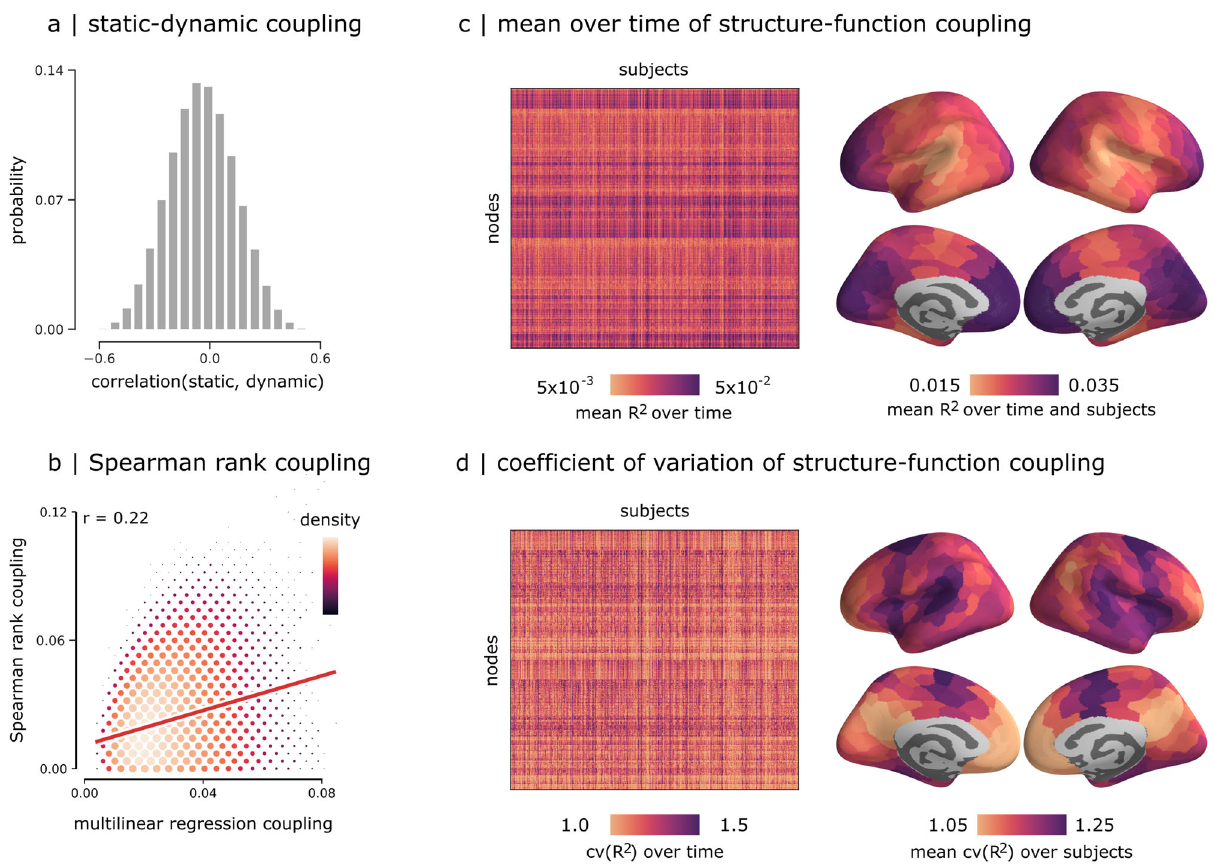
Fig. 2 Dynamic structure-function coupling. a Correlations between regional patterns of static and dynamic structure-function coupling. b Correlations between dynamic structure-function coupling estimated using a multilinear model 23 versus coupling estimated using an alternative Spearman rank correlation method 21 . Scatter color and size represent the density. c Mean time-resolved structure-function coupling over time (left) and its mean over subjects (right). d Coef fi cient of variation of structure-function coupling across time (left), and its mean over subjects